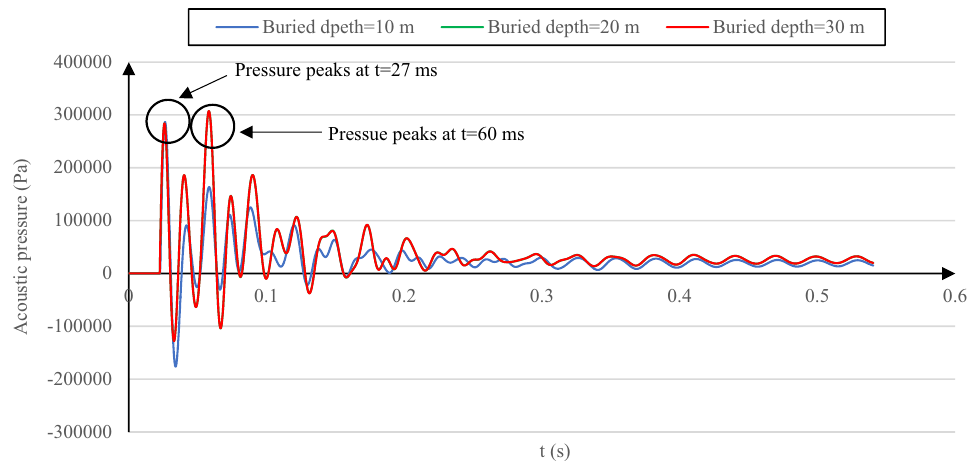
Figure 6. Reflected acoustic wave pressure–time history for the cases of 10-m, 20-m, and 30-m buried depth with reference soil properties. Note that the data associated with 20 and 30-m depths are almost